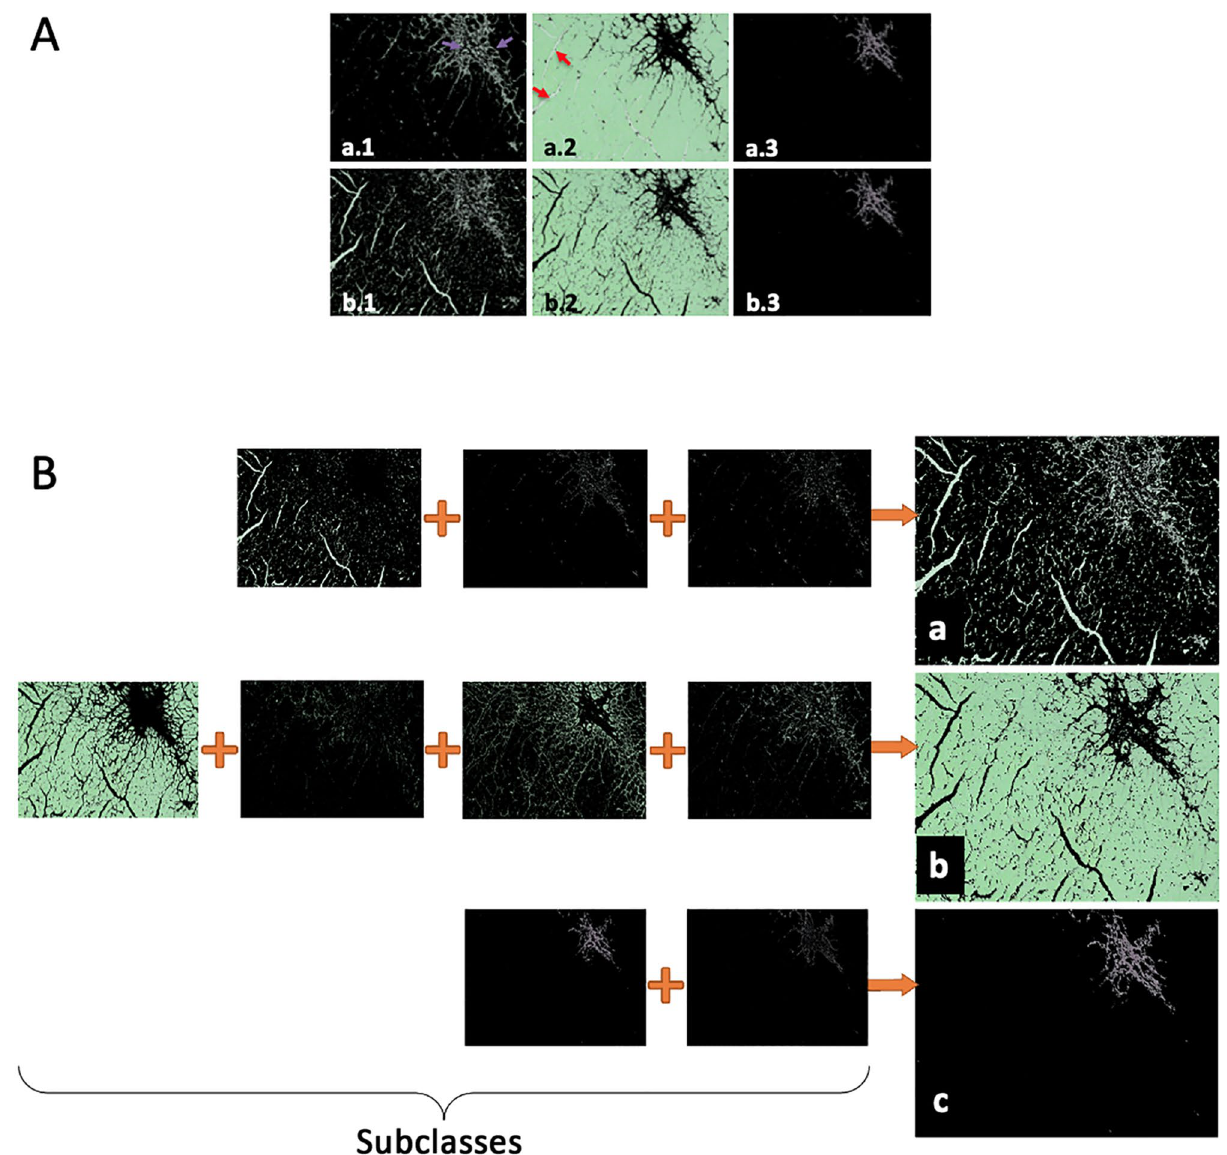
Figure 4. Workflow showing k -means classification with subclasses. ( A ) Standard k-means clustering results (a) compared to single step supervised k - means (b) with each of the three classes (1–3). Arrows depict partially falsely classified tissue, in a.1 healthy tissue is shown as background (yellow arrows), where background was falsely classified as healthy tissue in a.2. ( B ) Supervised single step k -means with subclasses (= multiple samples for each tissue type) showing improved combined results on all tissue types (a) background pixels, (b) healthy tissue, and (c) fibrotic and increased LV mass, measured by echocardiography (Fig. 5A,B). In addition, we could detect a marked eleva- tion of collagen 1 expression in myocardium following TAC as compared to respective controls (Fig. 5C,D). Further, we analysed the fibrotic tissue segmentation for Picosirius Red and Masson’s Trichrome staining using FibroSoft and compared it to the values obtained through Western blot analysis. We particularly focused our analyses on the left ventricle, since pressure overload induced by TAC induces left ventricular remod- eling and dysfunction. As depicted in Fig. 5E,F,G,H,I,J and Table 1, the use of our designed software proves a significant difference between fibrosis levels in sham versus TAC cardiac left ventricular samples of a similar magnitude as Western blot analysis. Moreover, fibronectin levels followed the same pattern, as demonstrated by immunohistochemistry experiments (Supplementary Figure. 4). To compare the feasibility and performance of our software we analyzed histology staining of each mouse accordingly to its corresponding Western blot data set. Most importantly, the values obtained with the two independent methods strongly correlate, evaluated in individual mice (Fig. 5F,I, Table 2).